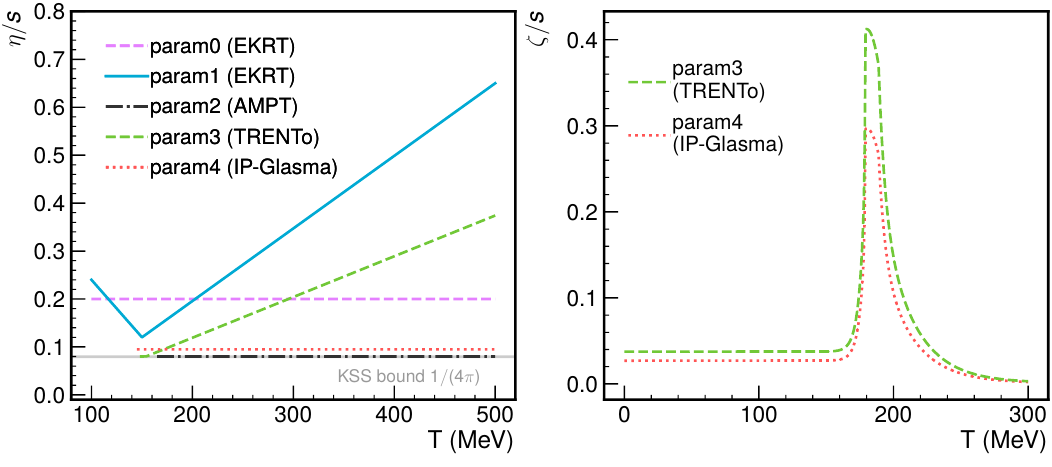
Figure 1 . The (cid:12)ve di(cid:11)erent parameterizations of (cid:17)=s and (cid:16)=s used for the di(cid:11)erent hydrodynamic model calculations are shown in the left and right panel. Note that the functional form of (cid:16)=s ( T ) is the same for param3 and param4 and taken from eq. 5 in [45] motivated by refs. [43, 93{95]. For the parameters with TRENTo initial condition, the ones based on identi(cid:12)ed yields are taken from table 4 in [45]. The (cid:16)=s normalization factor used with IP-Glasma (TRENTo) initial conditions is 0.9 (1.25). The models with (cid:16)=s = 0 are not shown on the right.